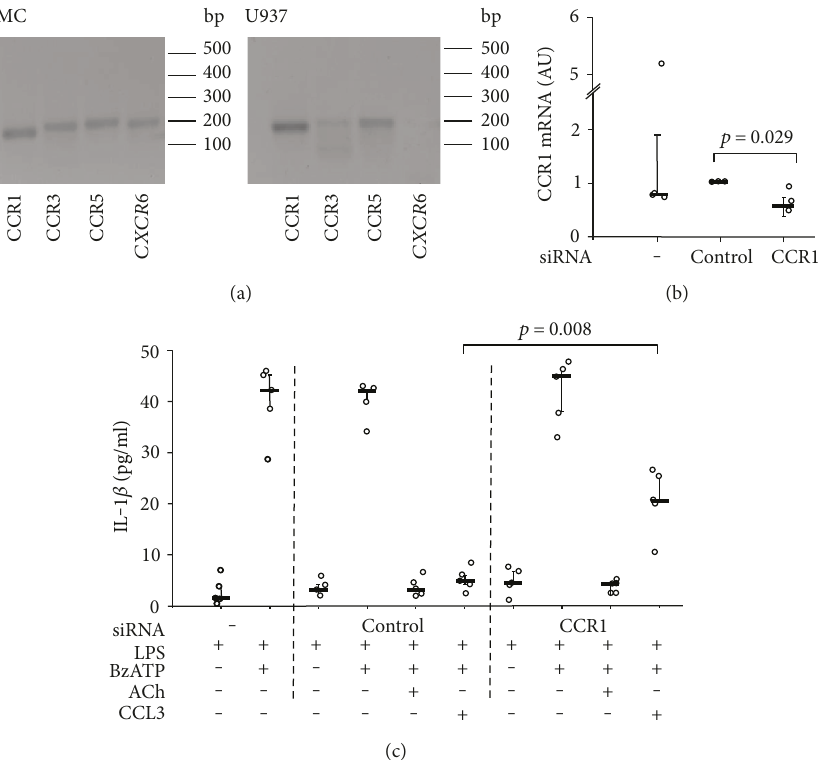
Figure 3: Signaling via chemokine receptor CCR1. (a) The mRNA expression of chemokine receptors CCR1 , CCR3 , CCR5 , and CXCR6 was investigated in U937 cells by real-time RT-PCR, and the amplicons were separated by gel electrophoreses together with a base pair (bp) ladder and detected by GelRed ™ Nucleic Acid Dye. Peripheral blood mononuclear cells (PBMC) obtained from healthy volunteers served as positive control. (b, c) U937 cells were transfected with scrambled control siRNA or with siRNA targeting CCR1 . These cells were primed with LPS (1 μ g/ml, 5h) followed by activation with 2 ′ (3 ′ )-O-(4-benzoylbenzoyl)adenosine-5 ′ -triphosphate (BzATP) (100 μ M, 30min). (b) The e ffi ciency of the siRNA transfection was veri fi ed by real-time RT-PCR. Values obtained for cells treated with siRNA targeting CCR1 were statistically compared to those transfected with control siRNA. (c) IL-1 β was measured in the cell culture supernatant by ELISA. In untreated and in control-transfected cells, CCL3 (10 ng/ml) fully inhibited the BzATP-induced release of IL-1 β , whereas silencing of CCR1 signi fi cantly blunted the inhibitory e ff ect of CCL3. In all experiments, acetylcholine (ACh; 10 μ M) was included as a positive control. Data are presented as individual data points, bars indicate median, and whiskers percentiles are 25 and 75; n = 5